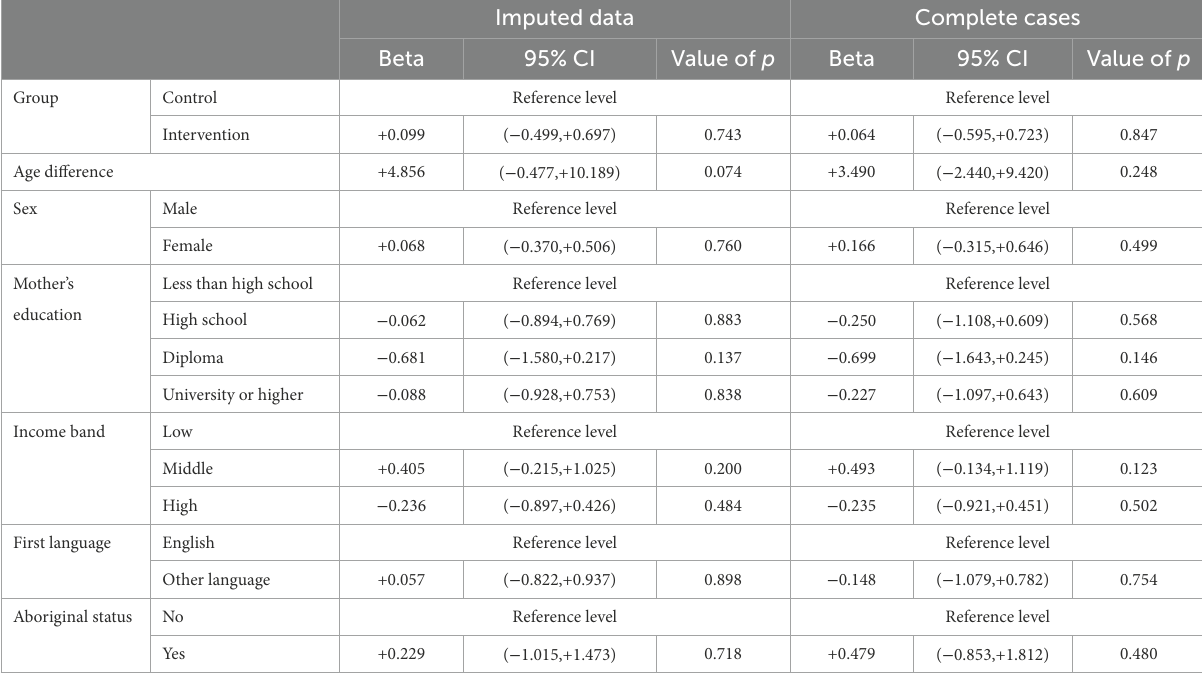
TABLE 10 Results of the regression model of difference between pre-and post-intervention EYT expressive vocabulary scores; models fitted to multiply imputed data ( N = 1,118) and to complete cases only ( N =